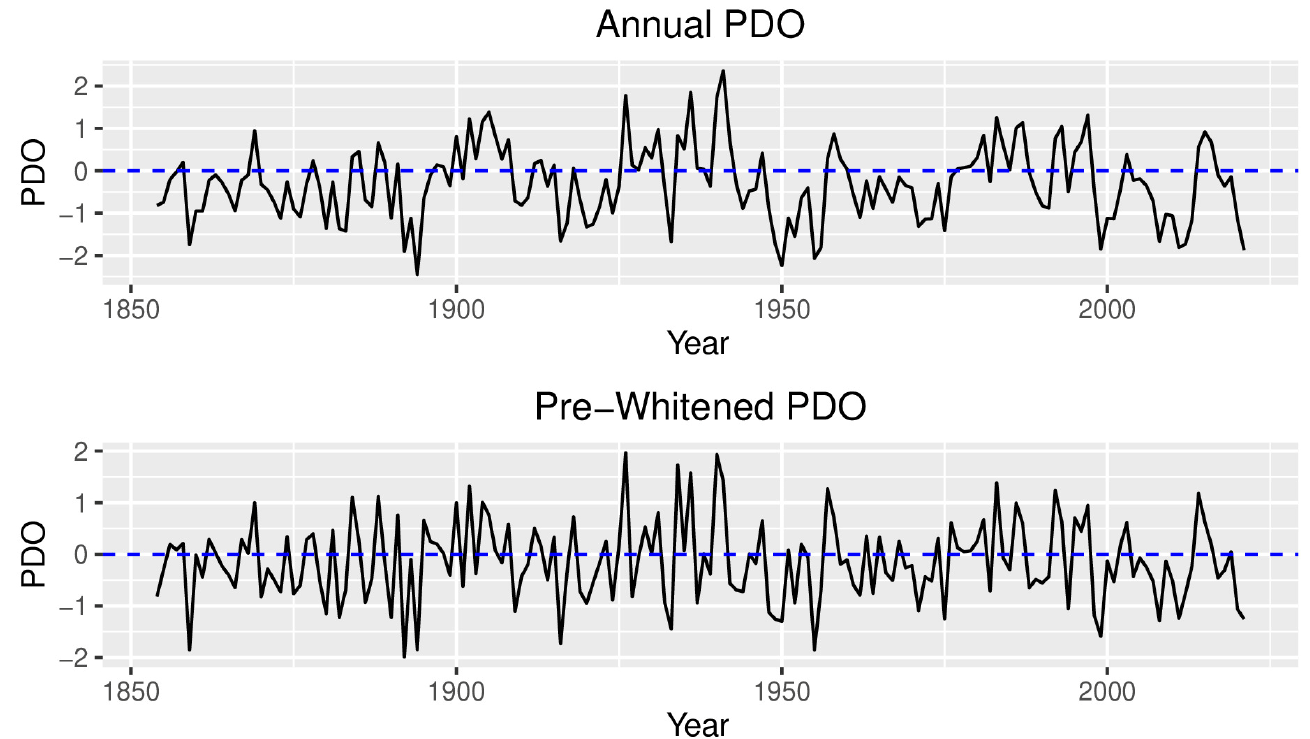
Figure 5. Change Points in PDO. The top panel shows the annual PDO values, while the bottom panel shows a pre-whitened version of this dataset. The horizontal dotted line at 0 is for reference to help identify positive and negative phases of the PDO. The Bayesian change point algorithm did not detect any change points in this dataset.